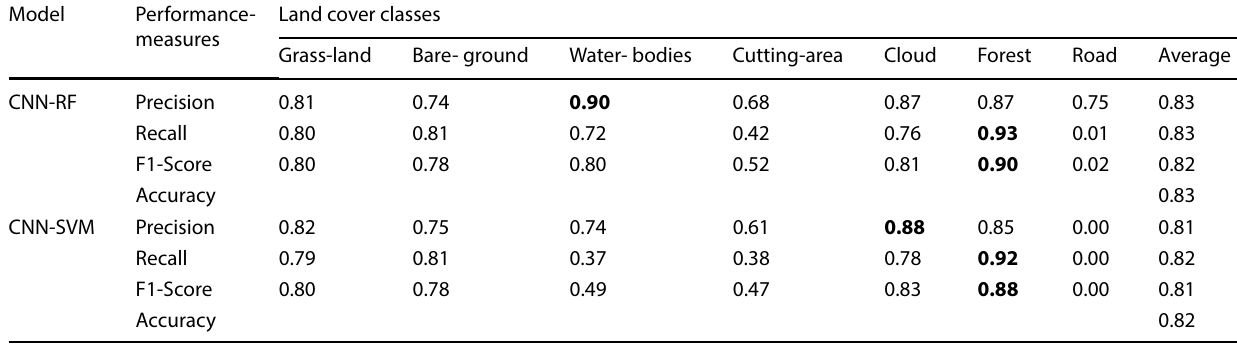
Table 3 Summary of performance measures for CNN-RF and CNN-SVM models